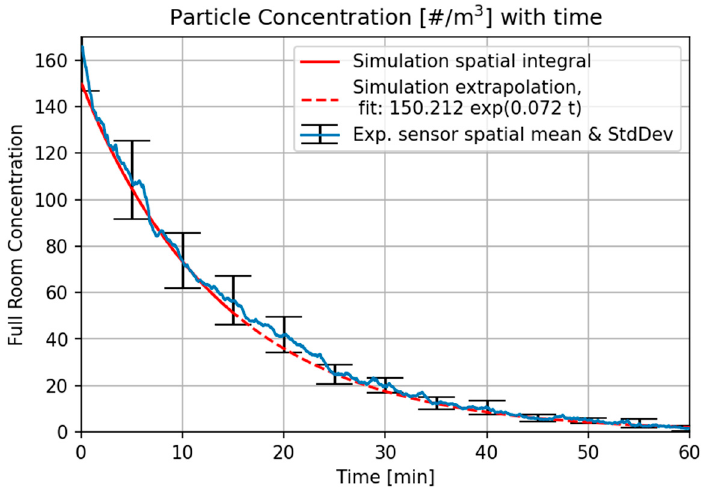
Figure 8. Comparison of the analytical, experimental and simulated particle decay curves measured as number of particles per cubic centimeter [#/m 3 ].